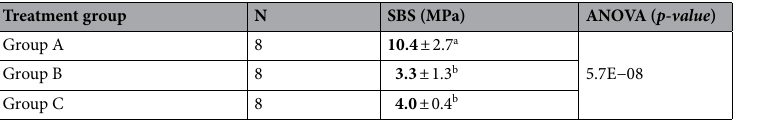
Table 3. Shear Bond Strength mean values and standard deviations of the three groups. Ref. SBS Values expressed in megapascal (MPa); Different letters express statistical differences a,b p < 0.05 (Scheffé test).